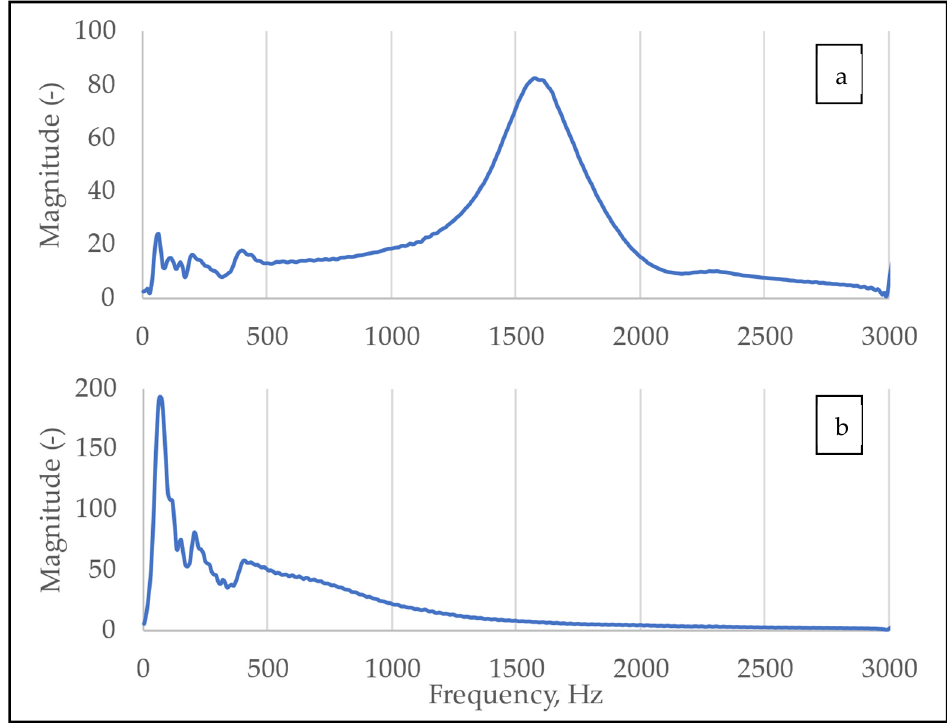
Figure 6. Spectra of the signals in NS ( a ) and EW ( b ) positions.